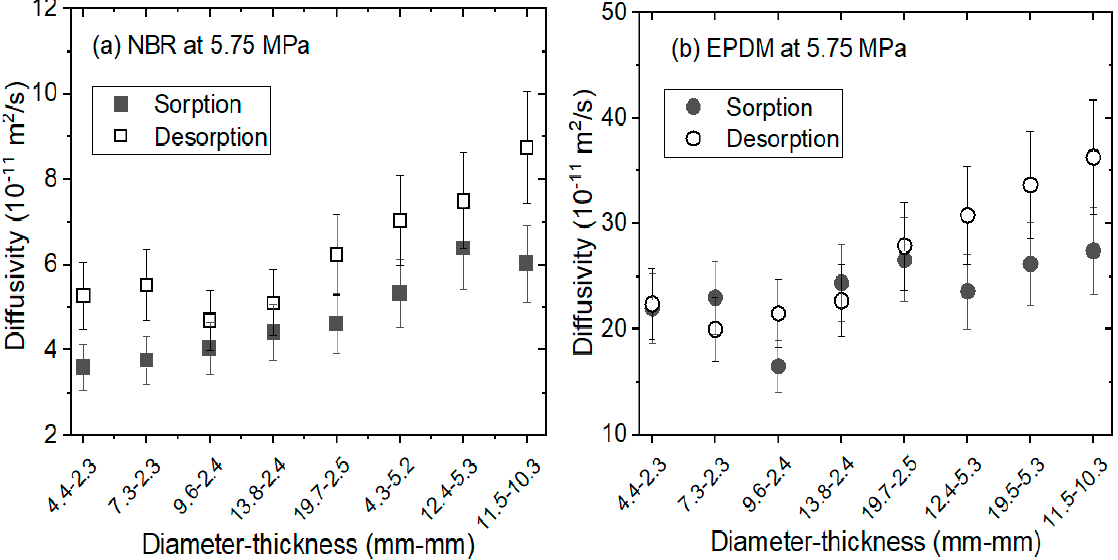
Figure 4. Comparison of the diffusion coefficients ( D s and D d ) versus sample volume for cylindrically-shaped ( a ) NBR and ( b ) EPDM exposed to 5.75 MP and 296 K. D s and D d were obtained by the sequences in Figure 2a and b, respectively, with the application of the diffusion analysis program.